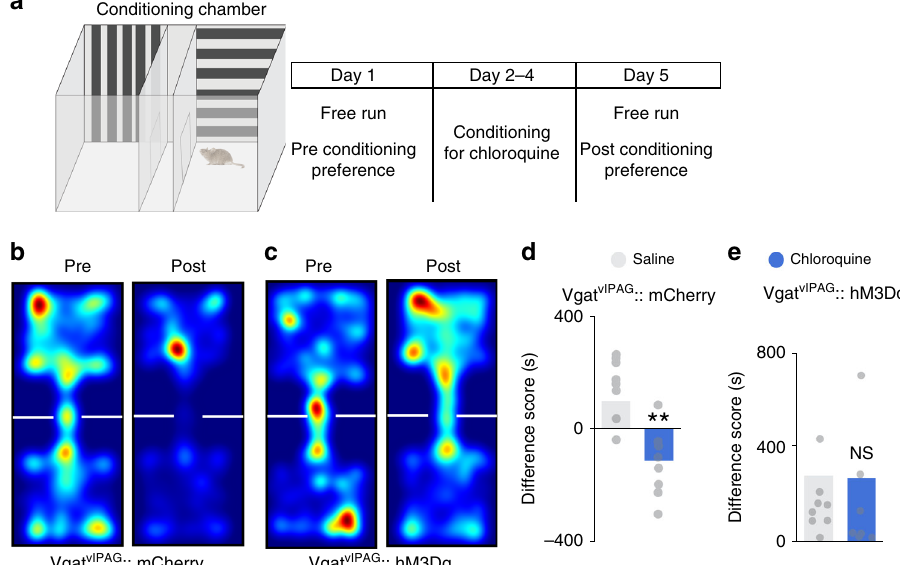
Fig. 6 vlPAG GABAergic neuronal activity modulates aversive component of itch. a Schematic of conditioned place aversion experimental design indicating saline-paired and chloroquine-paired chambers and the timing of each session in Vgat::hM3Dq and Vgat::mCherry mice. b Representative heat map showing location of a control mouse injected with mCherry in the vlPAG of Vgat Cre mice, pre and post chloroquine conditioning. (c Representative heat map showing location of a mouse injected with hM3Dq in the vlPAG of Vgat Cre mice, pre and post chloroquine conditioning. d CNO (5 mg/kg, i.p) administration in vlPAG::mCherry mice did not have any effect on the time spent in the chloroquine paired chamber compared to saline paired chamber ( N = 8, t test, t = 3.920, df = 13, ** P = 0.0018). e Activation of Vgat::hM3Dq neurons in the vlPAG with CNO (5 mg/kg, i.p) before mice were conditioned with chloroquine resulted in disruption of CPA to chloroquine ( N = 7, t test, t = 0.05297, df = 12 P = 0.9586). All values are mean ± SEM. Scale bars indicate 155 µ M. Source data are available as a Source Data fi